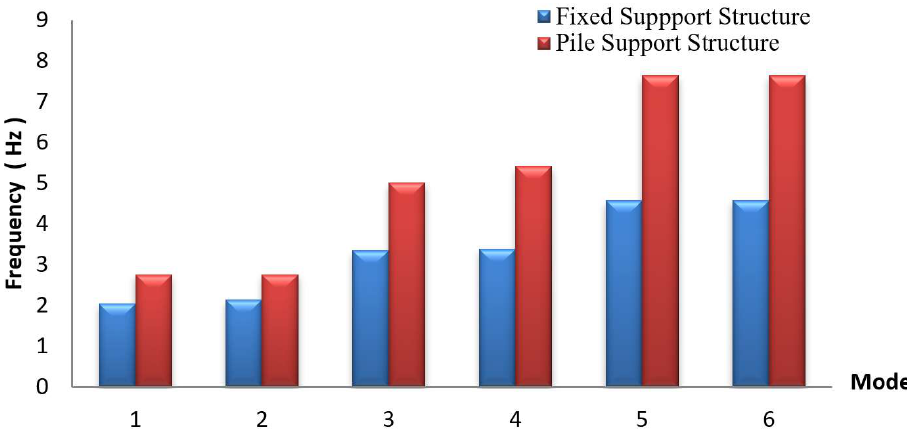
Figure 15. A comparison of the natural frequencies between the piled support structure and fixed support structure.